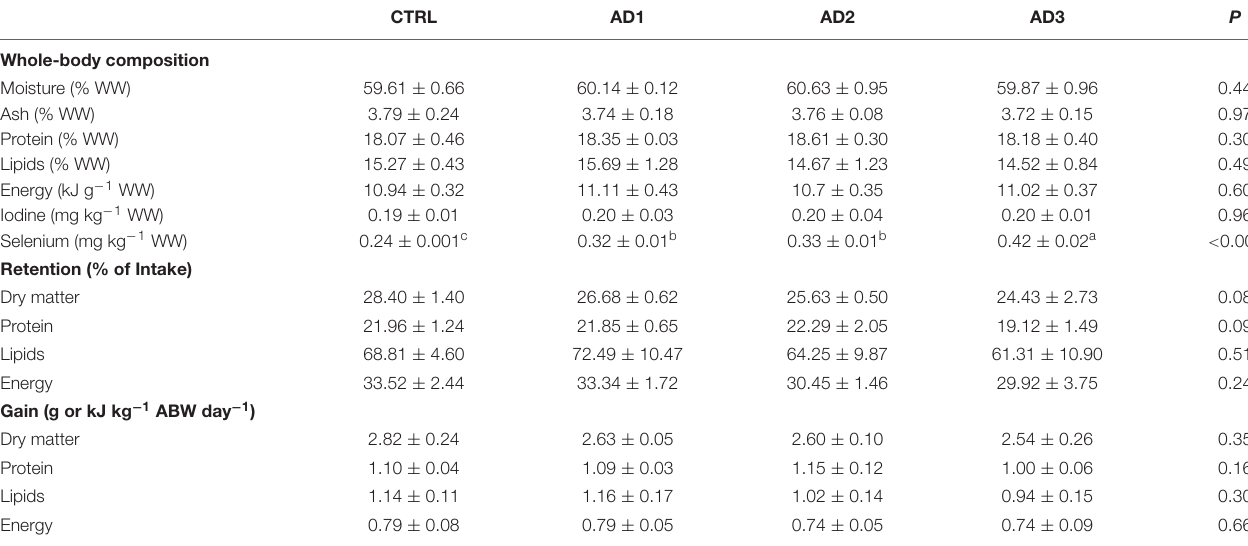
Values are presented as mean ± standard deviation (SD). Growth performance and intake parameters were calculated with three pooled samples per treatment of six fish per tank. Somatic indexes were calculated with 15 fish per treatment (five fish per tank). Different superscript letters in a row denote significant differences among treatments. TABLE 5 | Whole-body composition and nutrient retention and gain of gilthead seabream fed the experimental diets for 85